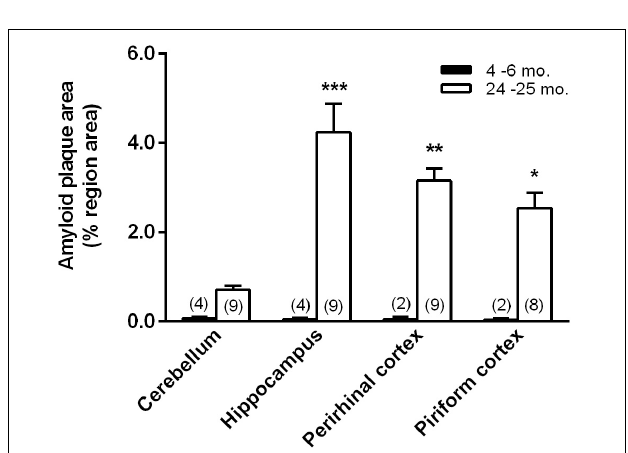
FIGURE 6 | Amyloid- β positive plaque areas as a percent of region area in the field of view in 4–6 and 24–25 months old TgF344-AD rats in cerebellum, hippocampus, perirhinal cortex, and piriform cortex. We had good sections from only one TgF344-AD rat at 12 months of age, so these data are not shown. The rat analyzed at 12 months of age was female and values for cerebellum, hippocampus, and perirhinal cortex were 0.33, 1.76, and 2.53%, respectively. These values were intermediate between the values in the 4–6 and the 24–25 month rats. Bars represent means ± SEM for the number of animals indicated in parentheses. We compared male (4) and female (5) values at 24–25 months of age by means of unpaired t -tests, and we found no significant sex differences in any region (cerebellum, p = 0.373; hippocampus, p = 0.730; perirhinal cortex, p = 0.674; piriform cortex, p = 0.477). As a consequence, further analyses were performed with males and females at each age combined. Data were analyzed by means of ANOVA with age and region as between subject variables. Main effects of both age ( F 1 , 39 = 51.25, p < 0.0001) and region ( F 3 , 39 = 5.459; p = 0.0031) were statistically significant. The age × region interaction was also statistically significant ( F 3 , 39 = 5.557; p = 0.003) so we compared the two ages in each region by means of Sidak’s corrected t -tests. Levels of statistical significance are denoted as follows: *, 0.01 ≤ p ≤ 0.05; **, 0.001 ≤ p ≤ 0.01; ***, p ≤